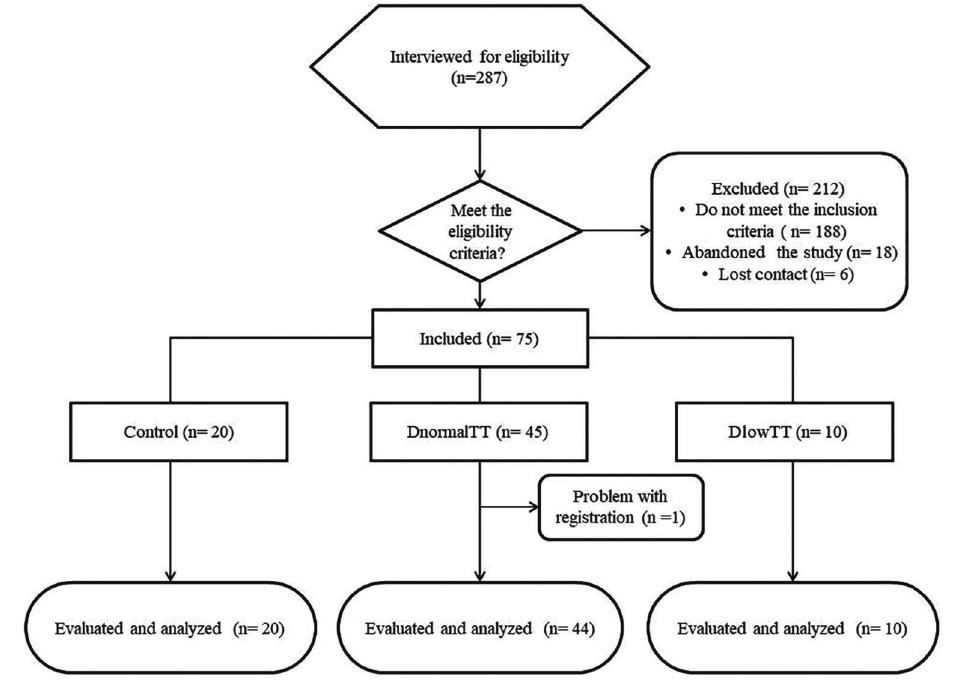
Figure 1. Flowchart of the study design. Control: control group; DnormalTT: diabetics with normal total testosterone; DlowTT: diabetics with low total